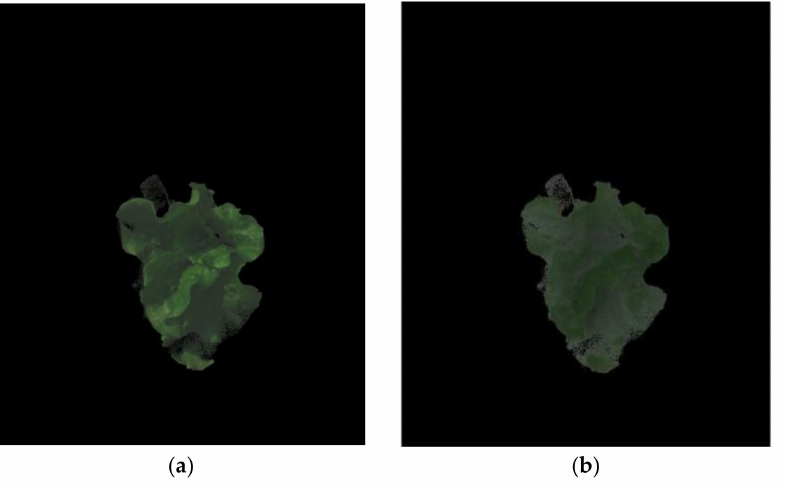
Figure 10. Light intensity correction comparison image. ( a ) Canopy images. ( b ) Light intensity corrected canopy